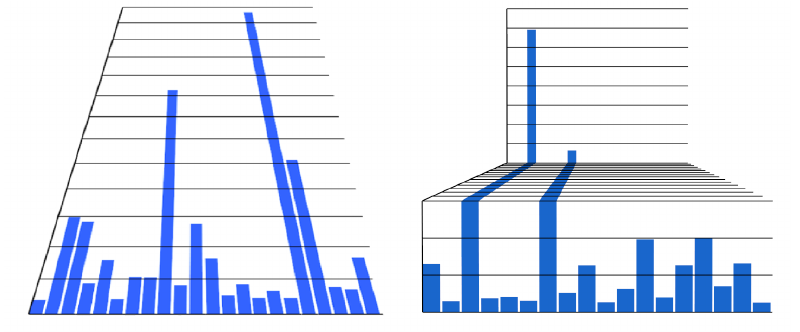
Figure 2. Slanted and stepped perspective chart designs